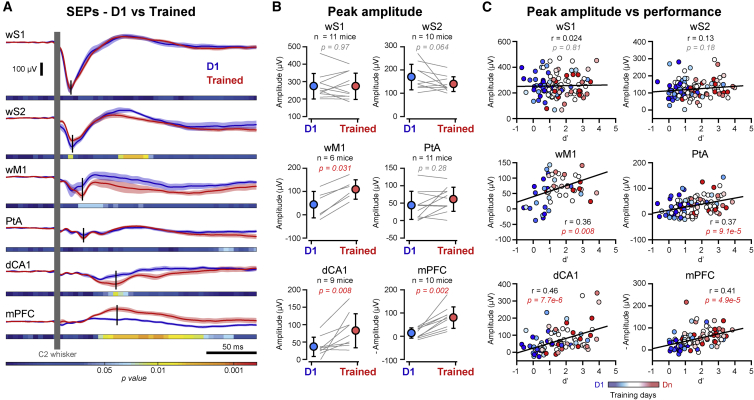
Sensory-Evoked Responses Correlate with Learning(A) Grand average SEPs computed for all stimulus trials, on the first training day (D1, blue) and after reaching good performance (Trained, red) for the same mice. Shaded areas indicate SEM. Horizontal bars indicate color-coded p values for statistical test of the difference between D1 and Trained conditions across time (Wilcoxon signed-rank test, D1 versus Trained for 5 ms time windows). Vertical black bars indicate the times of the peak responses.(B) Comparison of the peak amplitude of SEPs for D1 (blue) and Trained (red) conditions. Circles with bars indicate mean ± SD. Gray lines represent individual mice. Red p values indicate statistically significant differences between D1 and Trained (Wilcoxon signed-rank test).(C) Scatterplots of the day-by-day mean peak amplitude of the SEPs against performance (d’) for the six recorded areas. Each point represents one animal and one training session, color-coded according to the training day (from blue for D1 to red for the last training day). The correlation between the amplitude of the SEP and the daily performance was assessed using Pearson correlation with t statistic: the coefficient of correlation (r) and p values are indicated for each scatterplot.